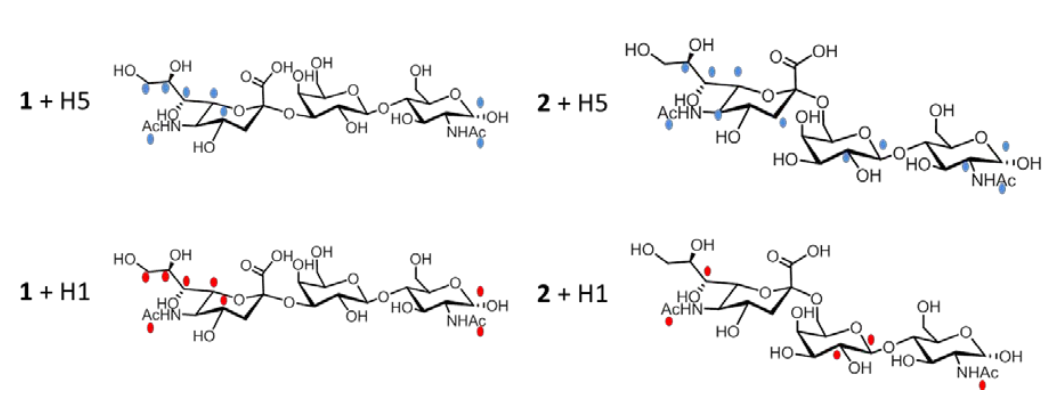
Figure 6. Protons of the epitope of compounds 1 and 2 in the presence of cells expressing HA are marked with blue dots for H5 and red dots for H1.